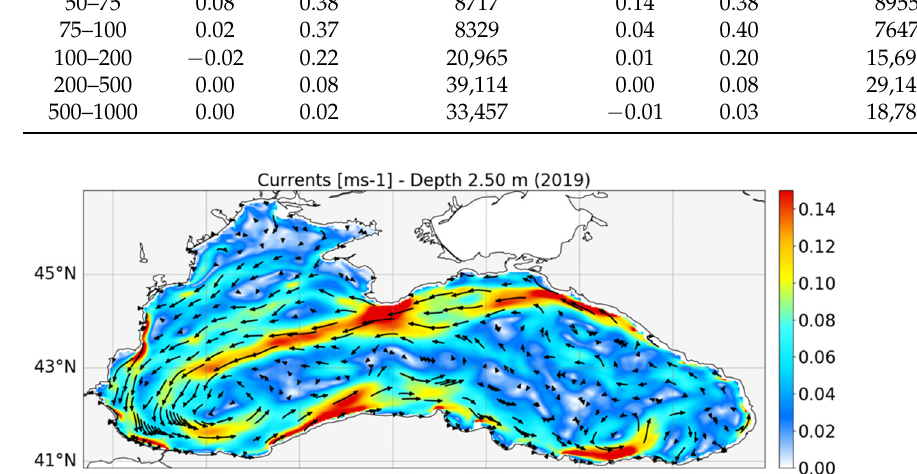
Figure 3. Surface currents in 2019.